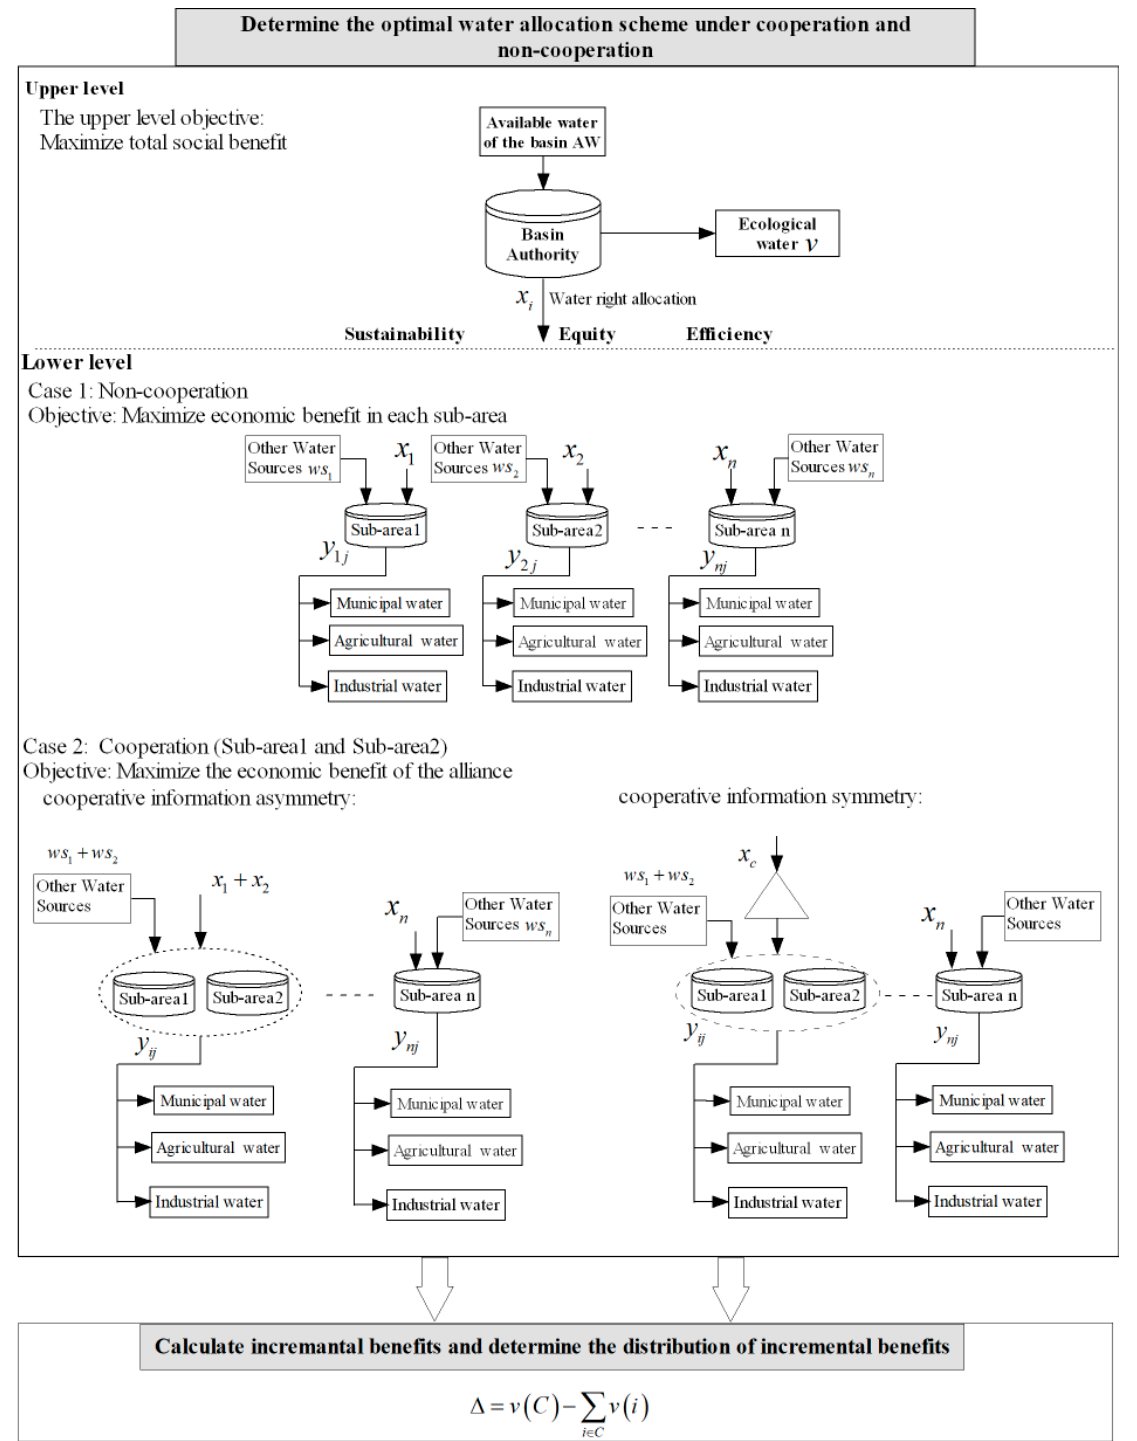
Figure 1. Process for determining the optimal water allocation scheme under cooperation and non-